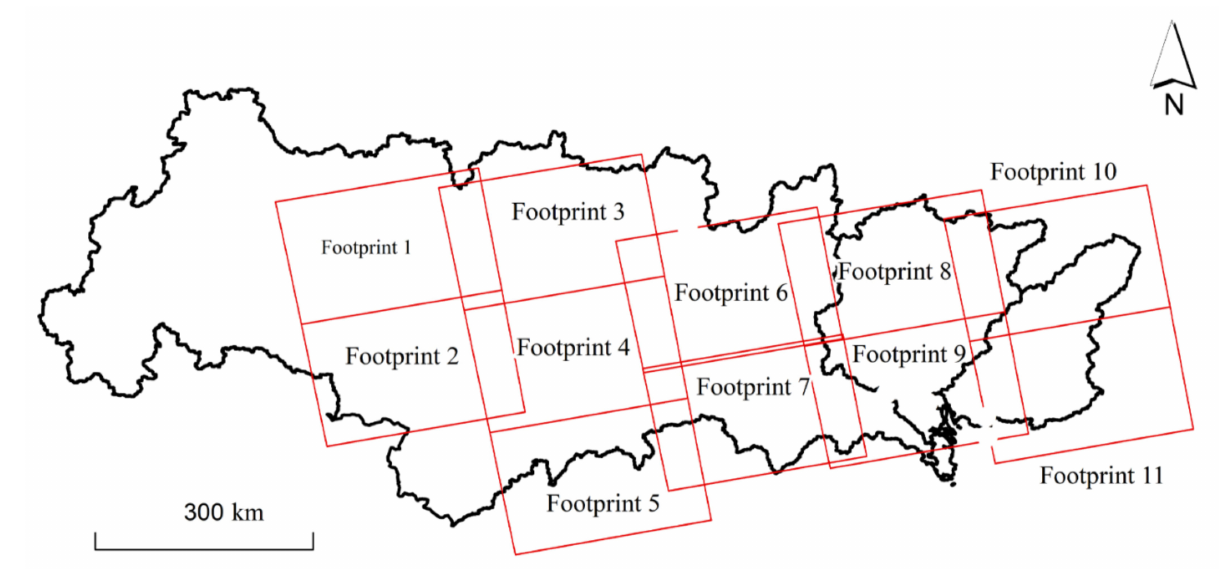
Figure 2. Locations of footprints of Sentinel-1